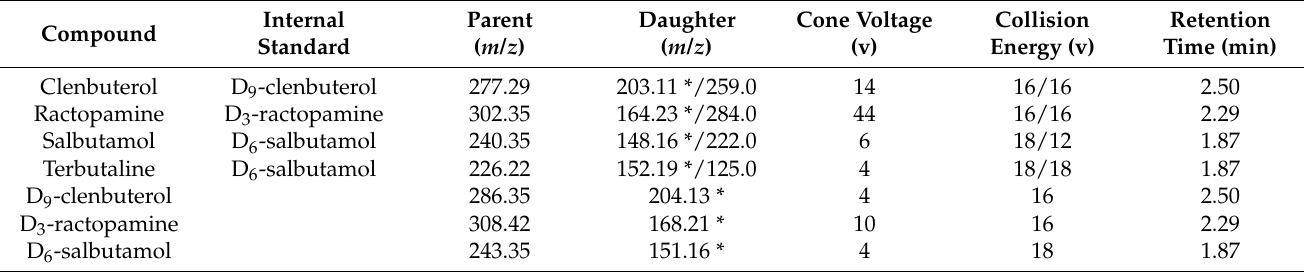
Table 2. Mass spectrometry parameters for the determination of β 2